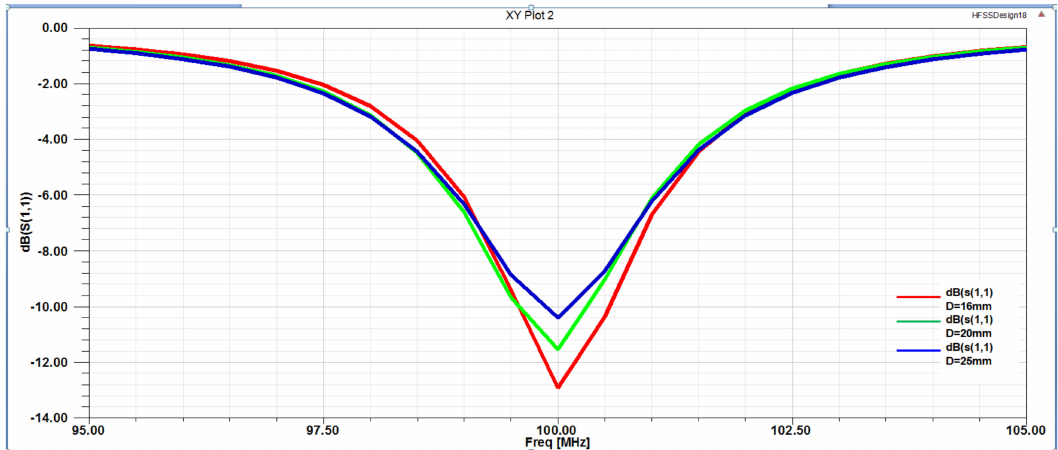
Figure 8. S11 parametric curves with unit spacings of D = 16, 20, and 25 mm.